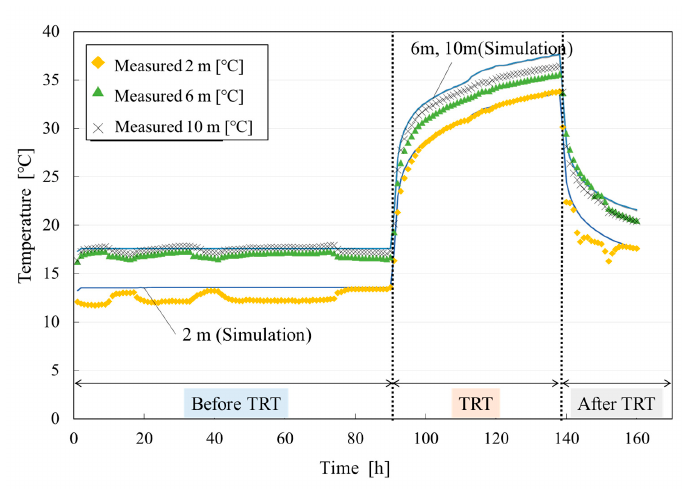
Figure 5. Comparison of U-tube surface temperatures at each depth.